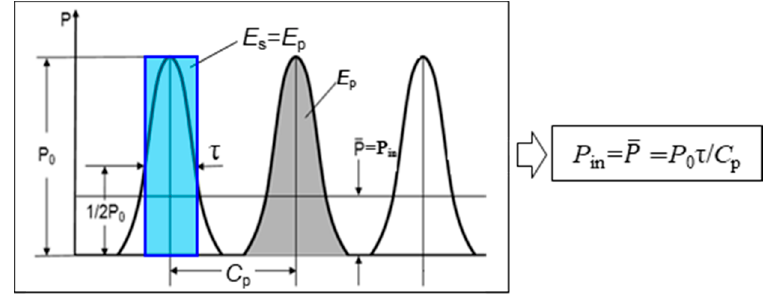
Figure 3. Waveform of the output power of a pulsed laser beam.